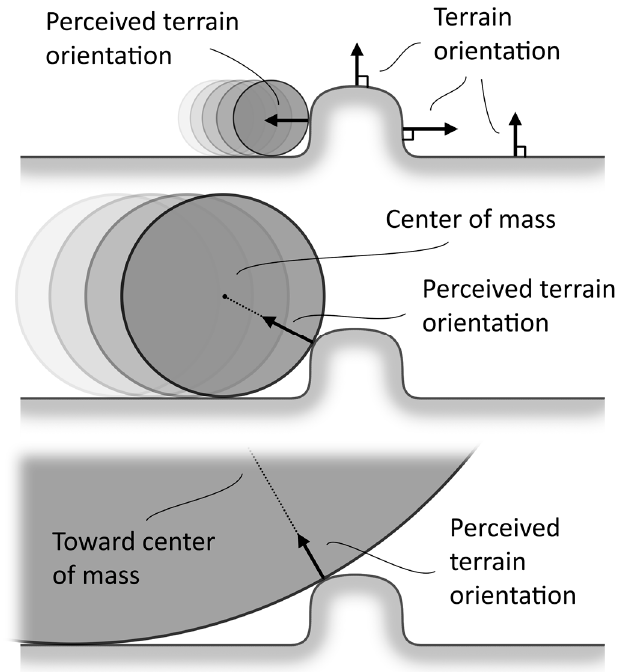
Figure 5. Distinction between the terrain orientation and the orientation perceived by rocks moving from left to right when encountering a local bump. Neglecting any scarring, the local terrain orientation does not change; however, the perceived orientation depends on the size of the rocks. For the smallest rock, all incident velocities can be decomposed as a normal component to the terrain. For the medium-sized rock, the normal velocity component is larger than the tangential velocity component. The normal velocity component is smaller than the tangent velocity component for the largest impacting rock. The smoothing effect of a low-resolution terrain model can also be illustrated by doubling the width of the local bump and reducing its height by half.